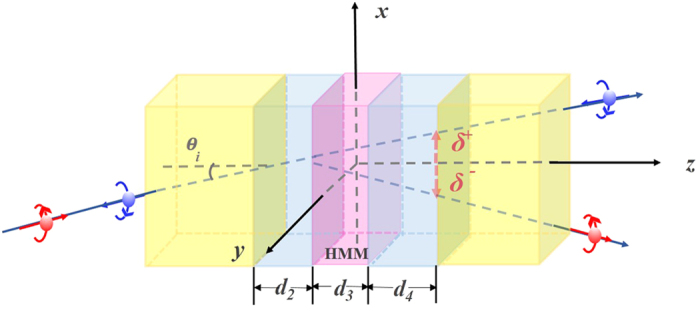
Schematic of SHE of tunneling light in a FTIR structure of SiO2-air-HMM-air-SiO2.